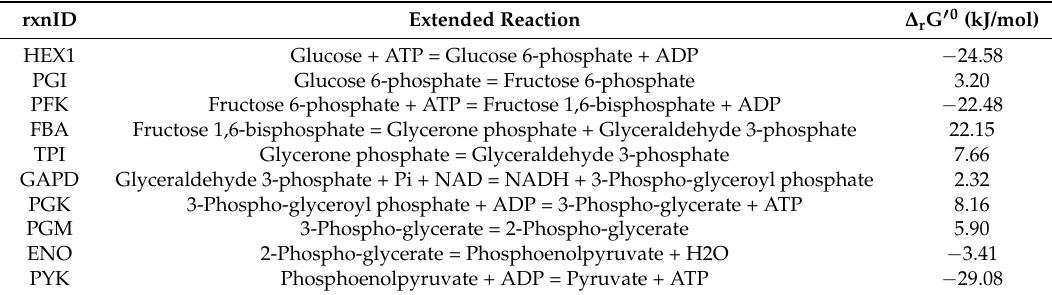
Table 2. Standard transformed Gibbs energy for reactions of glycolysis. HEX1: Hexokinase, PGI: Glucose 6-phosphate isomerase, PFK: Phosphofructokinase, FBA: Fructose-bisphosphate aldolase, TPI: Triose-phosphate isomerase, GAPD: Glyceraldehyde 3-phosphate dehydrogenase, PGK: Phosphoglycerate kinase, PGM: Phosphoglycerate mutase, ENO: Enolase, PYK: Pyruvate